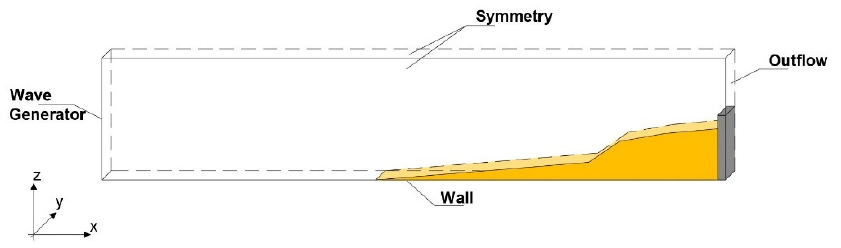
Figure 2. Boundary conditions of CFD 2D-domain.